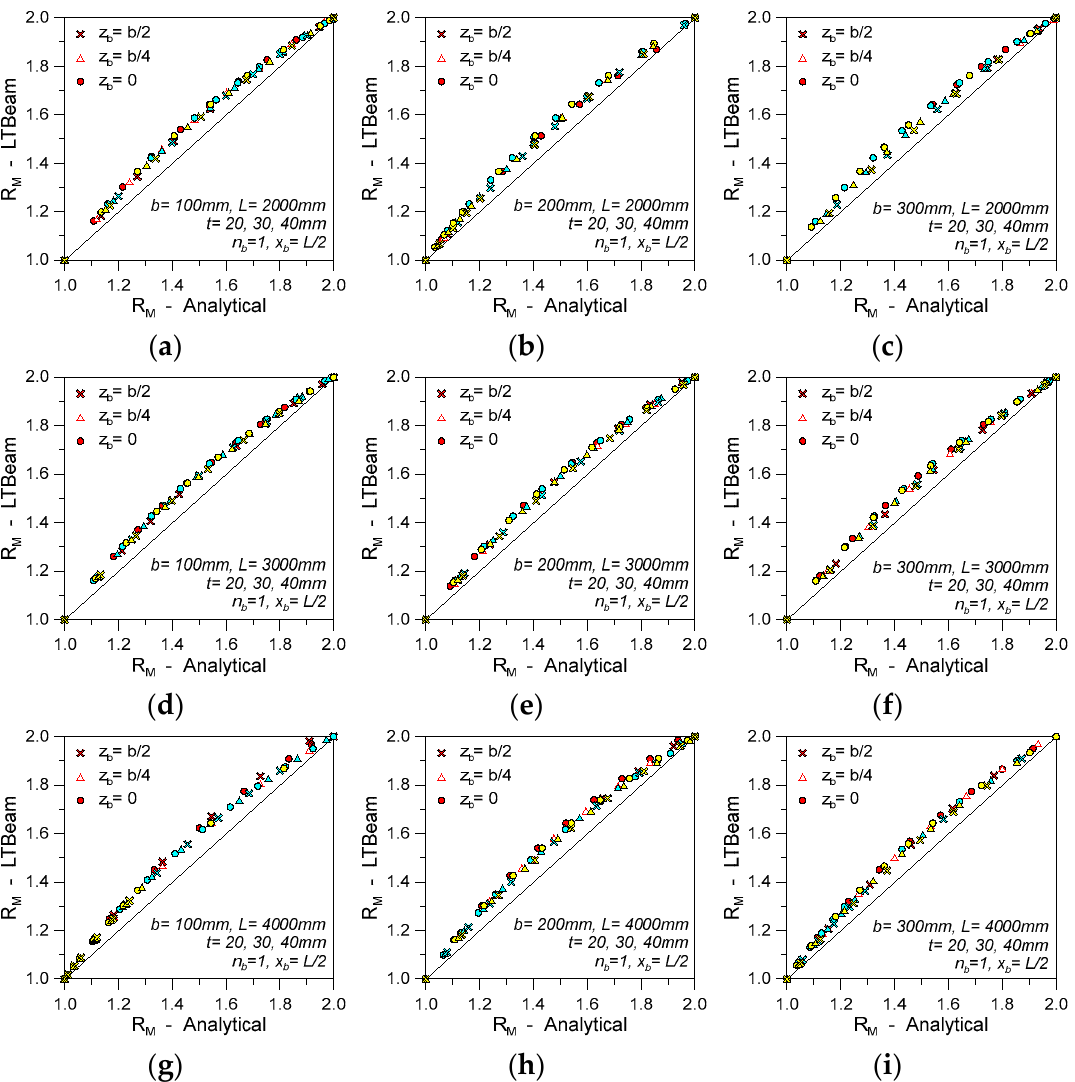
Figure 16. Comparative R M calculations (Equation (26)) for LR glass beams in LTB ( n b = 1, K = var).